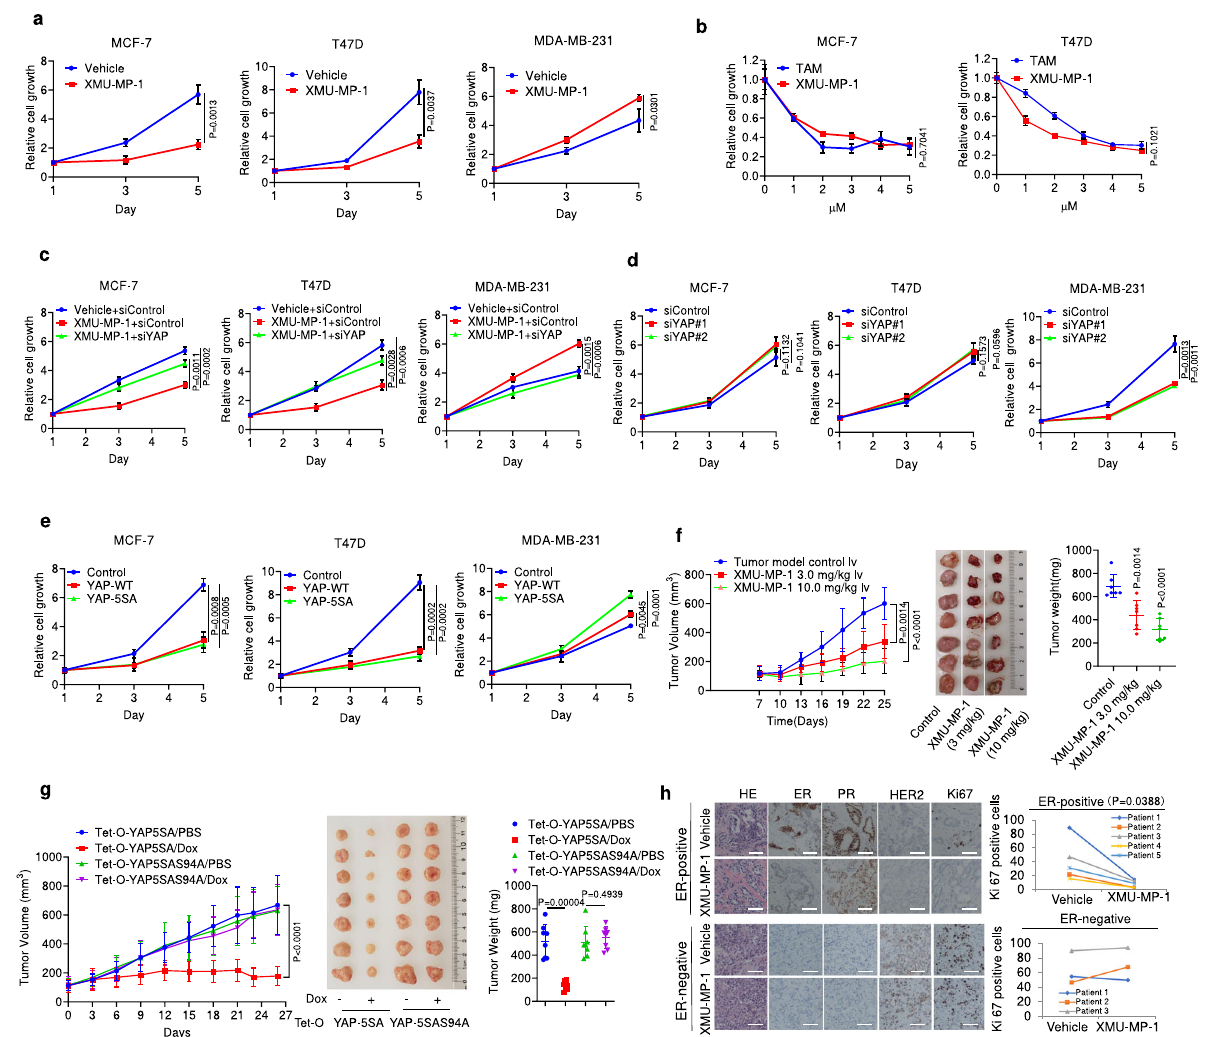
Fig. 2 YAP inhibits ER α -positive breast cancer cell growth. a XMU-MP-1 inhibits MCF-7 and T47D cancer cell proliferation but facilitates MDA-MB-231 cancer cell growth. b Comparison of inhibitory ef fi cacy between tamoxifen and XMU-MP-1 on MCF-7 and T47D cancer cell growth. c YAP siRNA blocked the inhibitory effect of XMU-MP-1 on MCF-7 and T47D cancer cell growth as well as the stimulatory effect of XMU-MP-1 on MDA-MB-231 cancer cell growth. d YAP depletion promoted MCF-7 and T47D but inhibited MDA-MB-231 cancer cell growth. e Overexpression of either wild-type YAP or YAP- 5SA inhibited MCF-7 and T47D but facilitated MDA-MB-231 cancer cell growth. f XMU-MP-1 inhibited ER-positive breast cancer growth in xenografts. Female NOD scid gamma (NSG) mice bearing MCF-7 tumors were treated daily with vehicle or XMU-MP-1 at the indicated concentrations. Tumor growth curve (left), photograph of tumor samples (middle), and quanti fi cation of tumor weight (right) at the end of treatment were shown, each group n = 7. g YAP-5SA but not YAP-5SAS94A inhibited ER-positive breast cancer growth in xenografts bearing MCF-7 cells that stably expressed the indicated constructs. The mice were injected i.p. with PBS containing Dox (20 mg/kg) or PBS daily for the indicated period of time. Tumor growth curve (left), photograph of tumor samples (middle), and quanti fi cation of tumor weight (right) at the end of treatment were shown, each group n = 7. h XMU-MP-1 inhibited cell proliferation of ER-positive breast cancer samples but did not inhibit ER-negative breast cancer patient samples in patient-derived explant (PDEx) assay. The patient-derived tumor samples were cultured ex vivo on gelatin sponges for 48 h with 10% FBS in the presence of 3 μ M XMU-MP-1 or vehicle. The tumor samples were fi xed and stained with ER α , PR, HER2, and Ki67 via IHC analysis (left). The dynamic change of Ki67 positive cells were counted and shown (right). Scale bars are 100 μ m. Results shown in a – e are representative of three independent experiments while results shown in f – h are based on one set of experiments. Data are means ± s.d. Two-side, unpaired t -test for a – h . Source data are provided in the Source Data fi